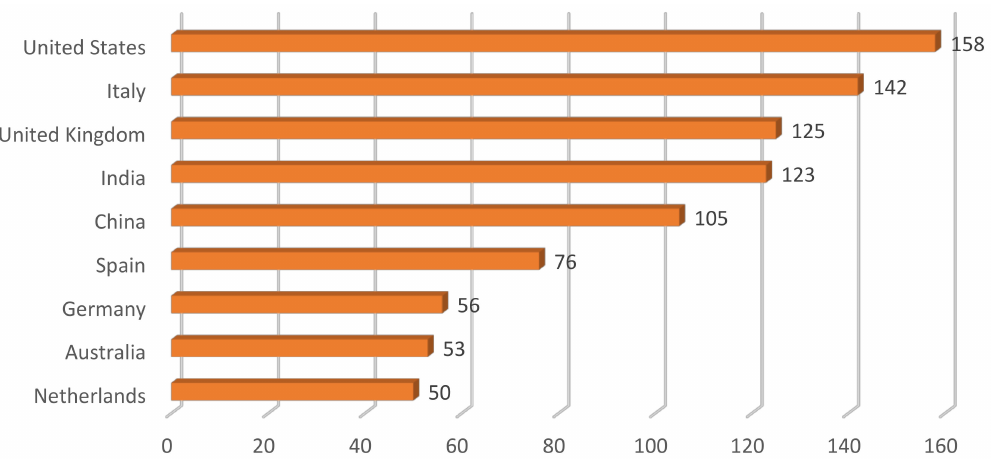
Figure 8. The list of the most productive countries (50 or more documents for the adopted